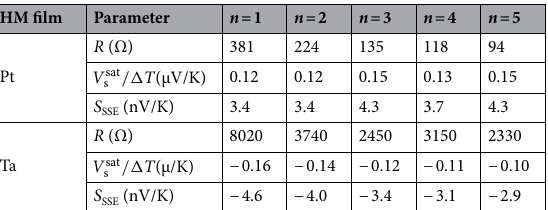
sat T , and S S /� SSE of [Pt or Ta film/Fe 3 O 4 NP] n films used in spin